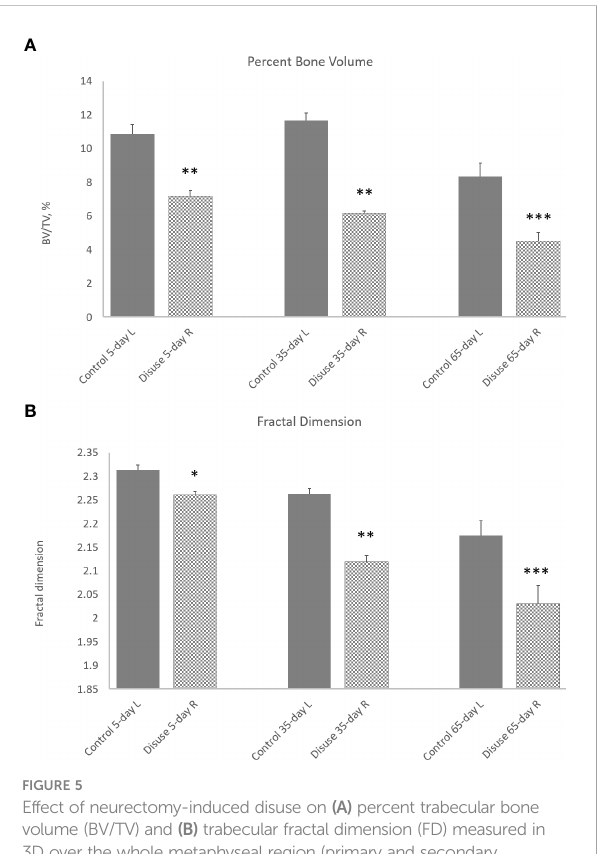
FIGURE 5 Effect of neurectomy-induced disuse on (A) percent trabecular bone volume (BV/TV) and (B) trabecular fractal dimension (FD) measured in 3D over the whole metaphyseal region (primary and secondary combined) at 5, 35, and 65 days post-operation. Grey bars, control left tibias; hatched bars, SN right tibias. * p < 0.05, ** p < 0.01, *** p <